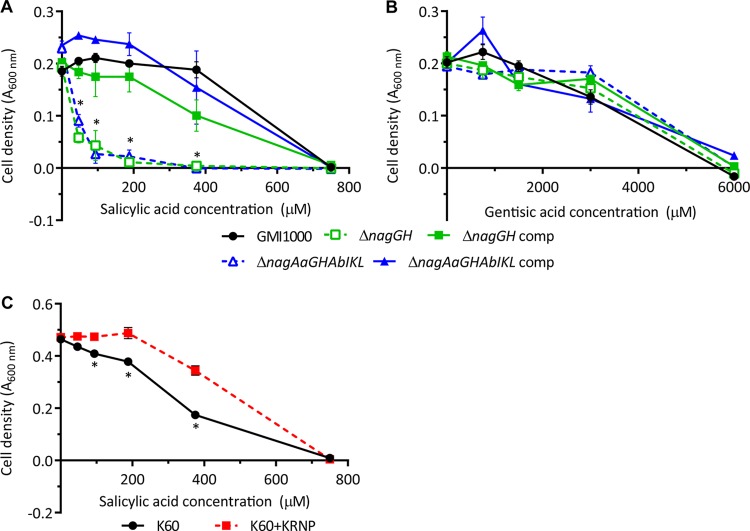
The Nag pathway protects R. solanacearum from toxicity of SA, but not from that of gentisic acid. Strains were grown in minimal medium plus succinate with increasing SA (A and C) or increasing gentisic acid supplemented with constant 10 µM SA (B) to induce nag gene expression. Cell density was measured based on the A600 after 48 h. The average results of three biological replicates with standard errors are shown. At time points marked with an asterisk, the SA-degrading strains (GMI1000 or K60+KRNP) grew better than strains that cannot degrade SA (the ΔnagGH and ΔnagAaGHAbIKL mutants and wild-type K60) (P < 0.005; Student’s t test).